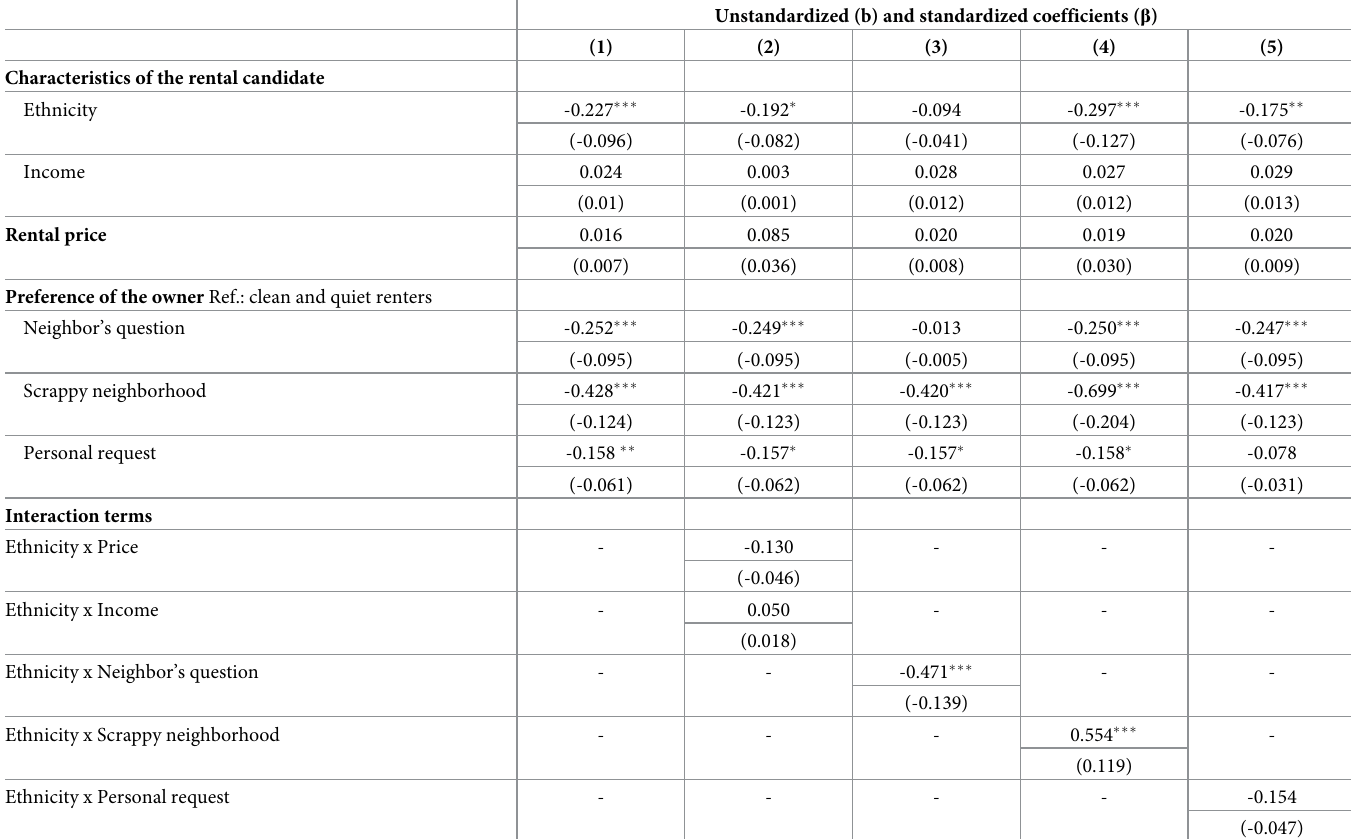
Table 5. Linear regression analyses of the neighborhood taste-based